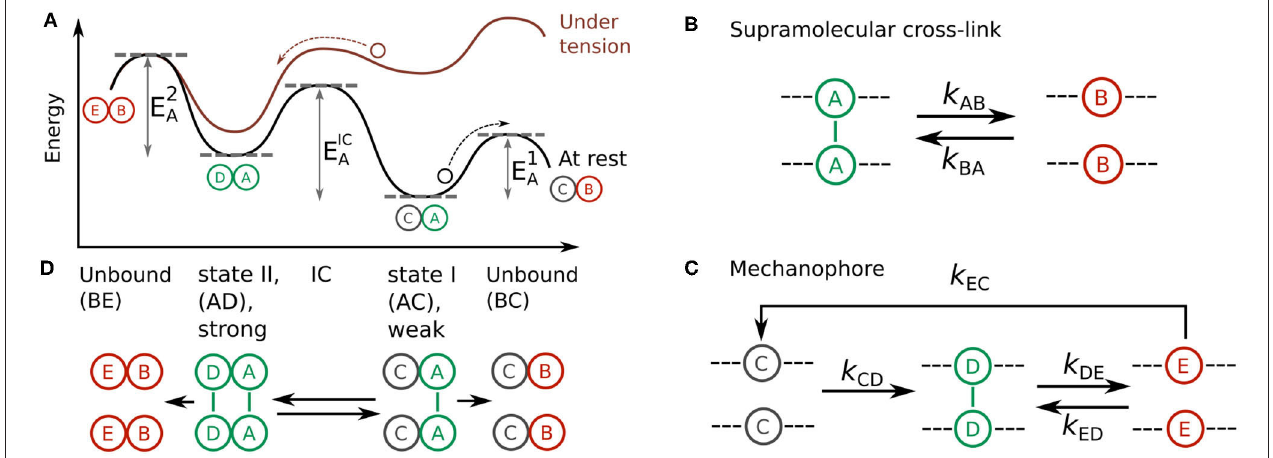
FIGURE 1 | (A) Energy landscape of a two-state, two-pathway catch bond at rest (black) and under tension (red). The activation energies of dissociation from state I, dissociation from state II, and interconversion between these states are shown as E 1 A , E 2 A , and E IC A , respectively. (B,C) Design model of a synthetic catch bond that consists of (B) a supramolecular cross-link and (C) a mechanophore capable of forming a supramolecular cross-link under force-activation. (D) Schematic representation of a catch bond consisting of one supramolecular cross-link and one mechanophore in weak state I (AC) and strong state II (AD), along with the two unbound states BC and BE that could be reached from these